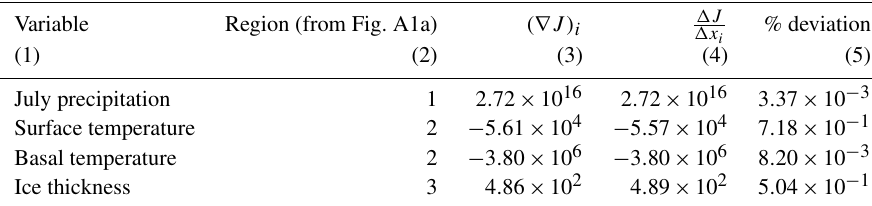
Table A1. Comparison between adjoint-derived (column 3) and finite-difference-derived (column 4) point-wise sensitivities for Greenland ice volume as QoI (symbols as in Table 1). All regions in column (2) refer to points from Fig. A1a. Column (5) is a percent deviation metric, | col .( 4 ) − col .( 3 ) | × which is calculated as col .( 4 )